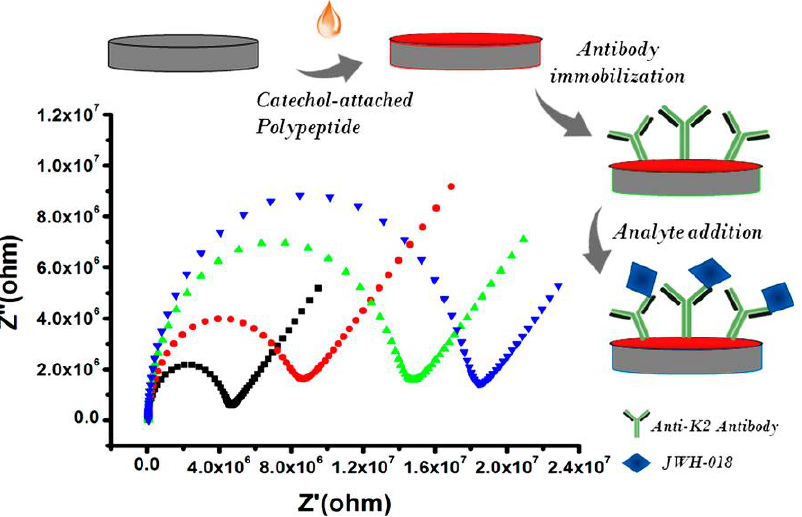
Figure 2. Development of the impedimetric immunosensor for the detection of JWH-018 ( N -4- hydroxypentyl metabolite. Each step of the sensor development is accompanied by an increase in Rct. Reproduced with permission from [70] Copyright (2020) American Chemical Society.